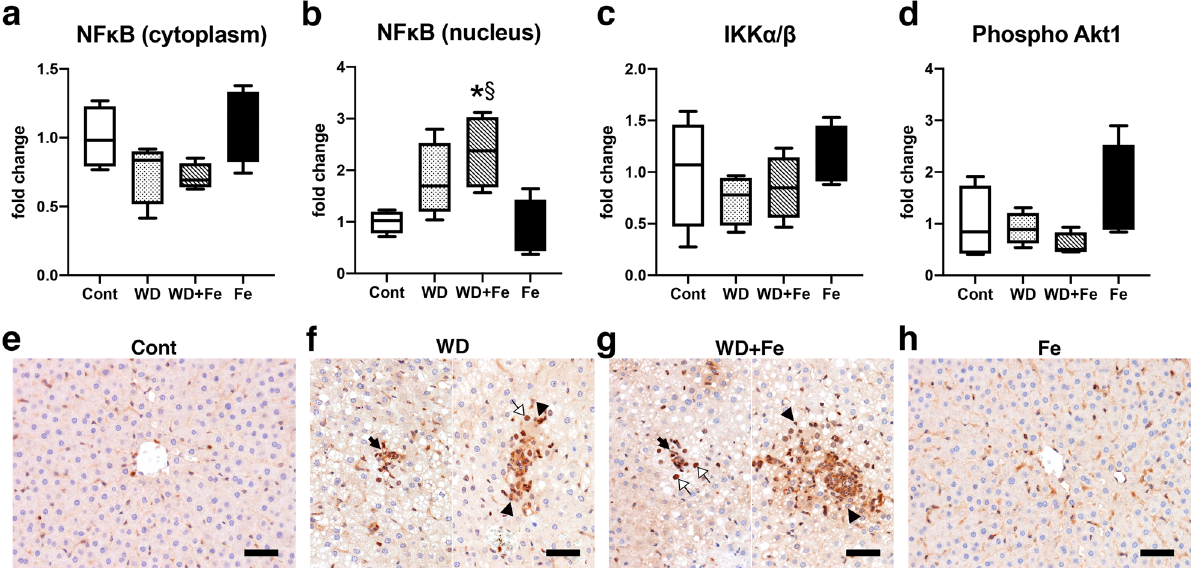
Figure 7. Hepatic expression of NFκB in the ( a ) cytoplasmic and ( b ) nuclear fractions, and ( c ) phospho IκB kinases and ( d ) phospho Akt in the whole liver tissue lysate at week 26. GAPDH and histone H2B were used for a loading control in the whole tissue/cytoplasmic and nuclear fraction, respectively. Data are expressed as fold change from control and are presented as box and whiskers (n = 4/group). * P < 0.05 versus Cont, § P < 0.05 versus Fe by one-way ANOVA followed by Tukey’s multiple comparison. Images of NFκΒ (p65 or RelA) immunohistochemistry in Cont ( e ), WD ( f ), WD + Fe ( g ), and Fe ( h ) groups. Bar = 50